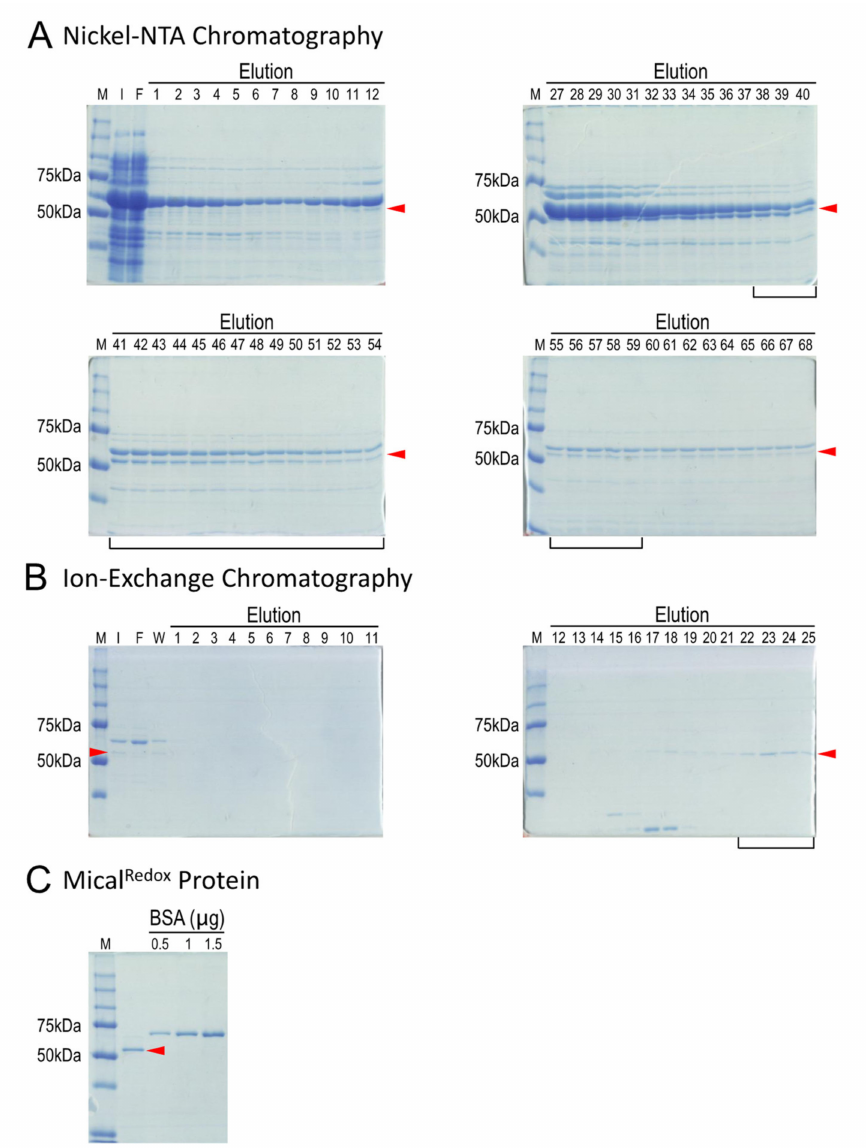
Figure 3. Purification of recombinant Mical Redox protein. Coomassie stained bands are shown and the arrowheads point to the His(6)-tagged Mical Redox protein in all gels. ( A ) Mical Redox protein (arrowhead) eluted from Nickel columns was observed in multiple fractions. Cpn60 can also be seen (large band above the Mical Redox protein). The fractions containing Mical Redox protein (e.g., 11–68) were combined to load on to an ion-exchange column. In this particular purification, only fractions 38–59 (black bracket) were combined and used for loading on the ion-exchange column. ( B ) A strong cation exchange Mono S column was used to separate Mical Redox protein (arrowhead) from other contaminating proteins including Cpn60. Fractions enriched with Mical Redox protein (22–25; black bracket) were combined and the buffer system was changed to the storage buffer. ( C ) Mical Redox protein (arrowhead) and purity were checked by running on a gel next to known concentrations of bovine serum albumin (BSA) protein. M, protein markers; I, input; F, flow-through; W,